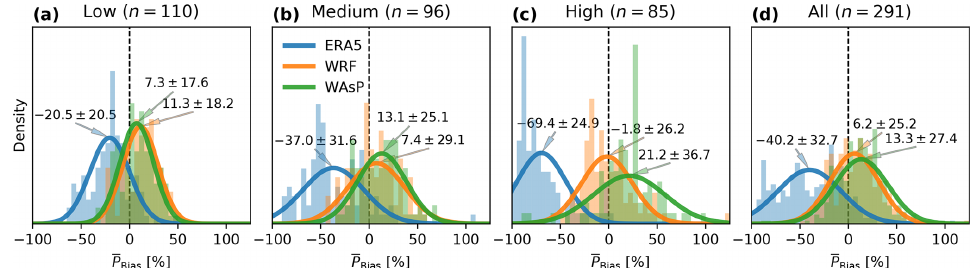
Figure 12. Distributions of the biases in mean generated power for the various stages of the model chain grouped by ruggedness index (RIX) category: low (a) , medium (b) , high (c) , and all of the samples combined (d) . The power was estimated by the modelled and observed wind climates combined with the NREL 5MW reference turbine power curve. Fitted normal distributions (lines) are annotated by the mean and standard deviation ( µ ± σ ). The number of masts ( n ) in each category is indicated above the